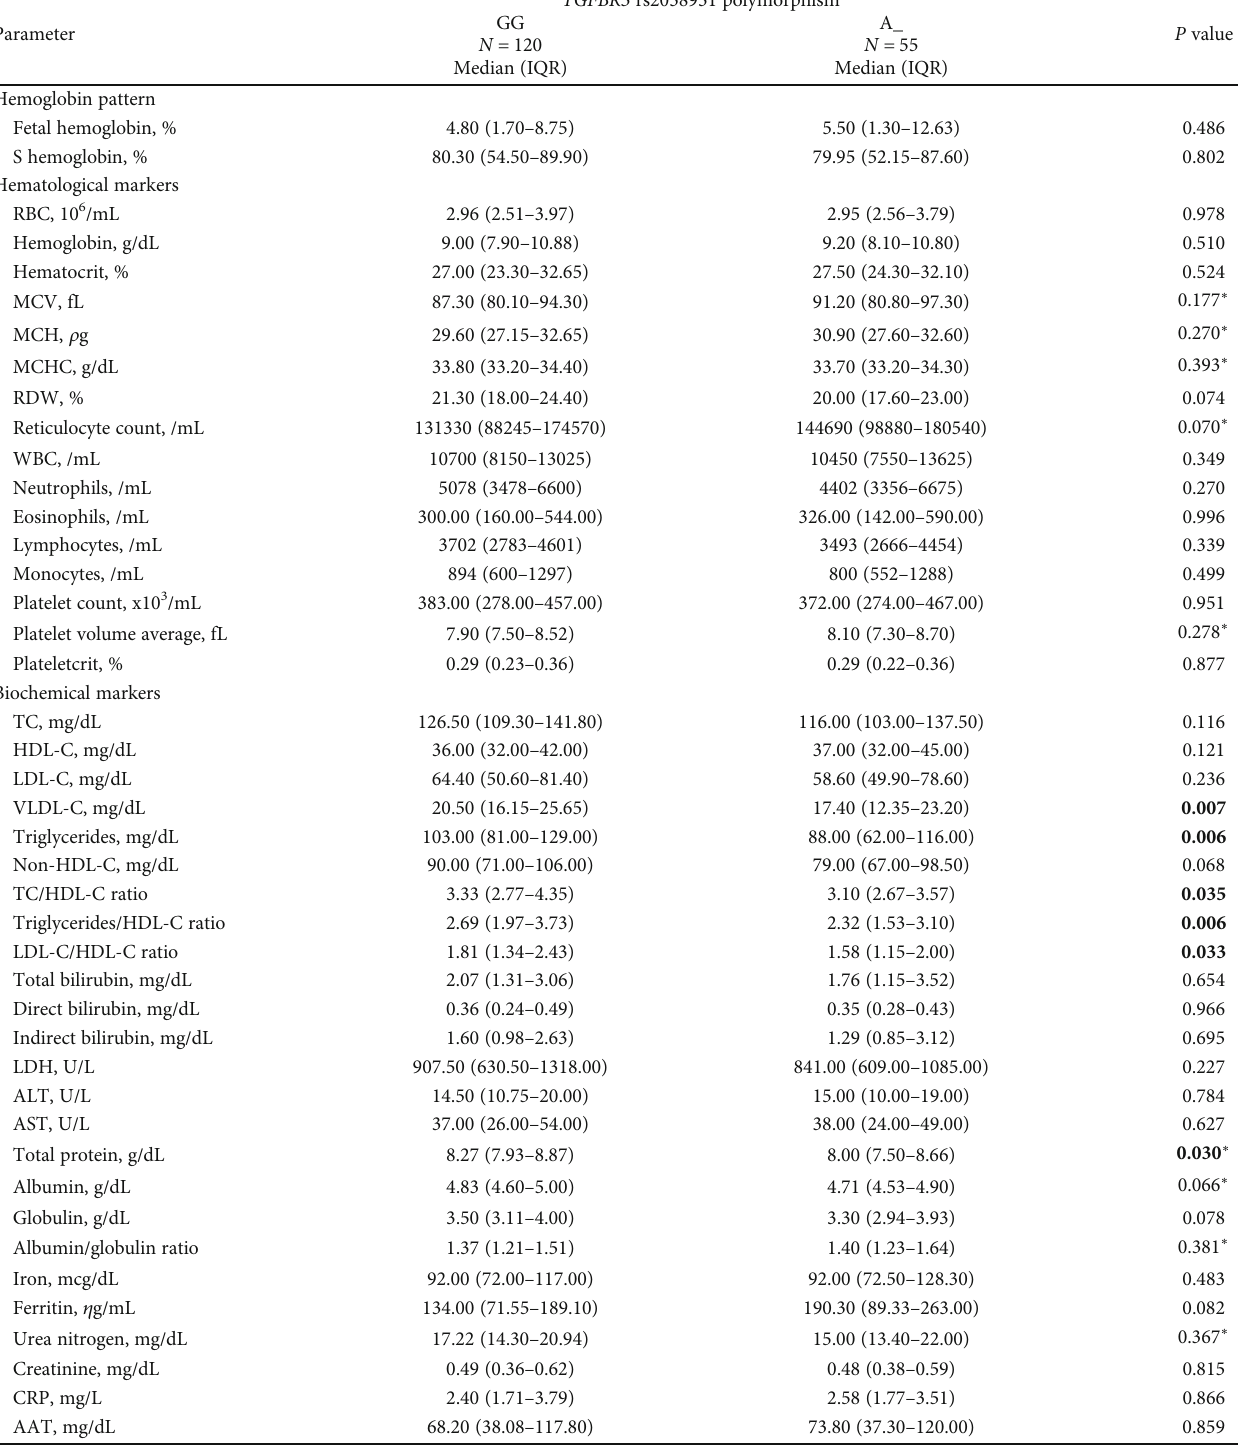
Table 4: Association of TGFBR3 rs2038931 polymorphism with laboratory biomarkers using the dominant genetic